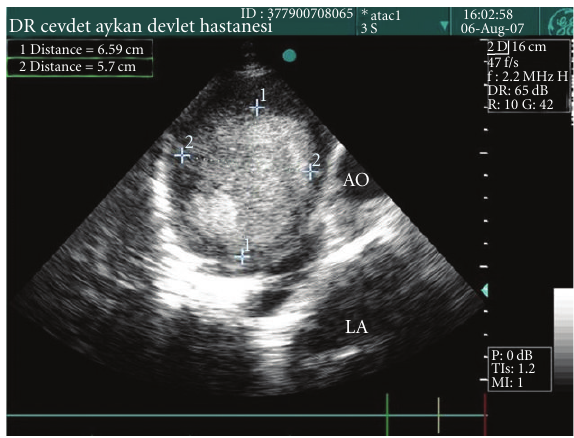
Figure 1: Paracardiac mass on transthoracic echocardiography.